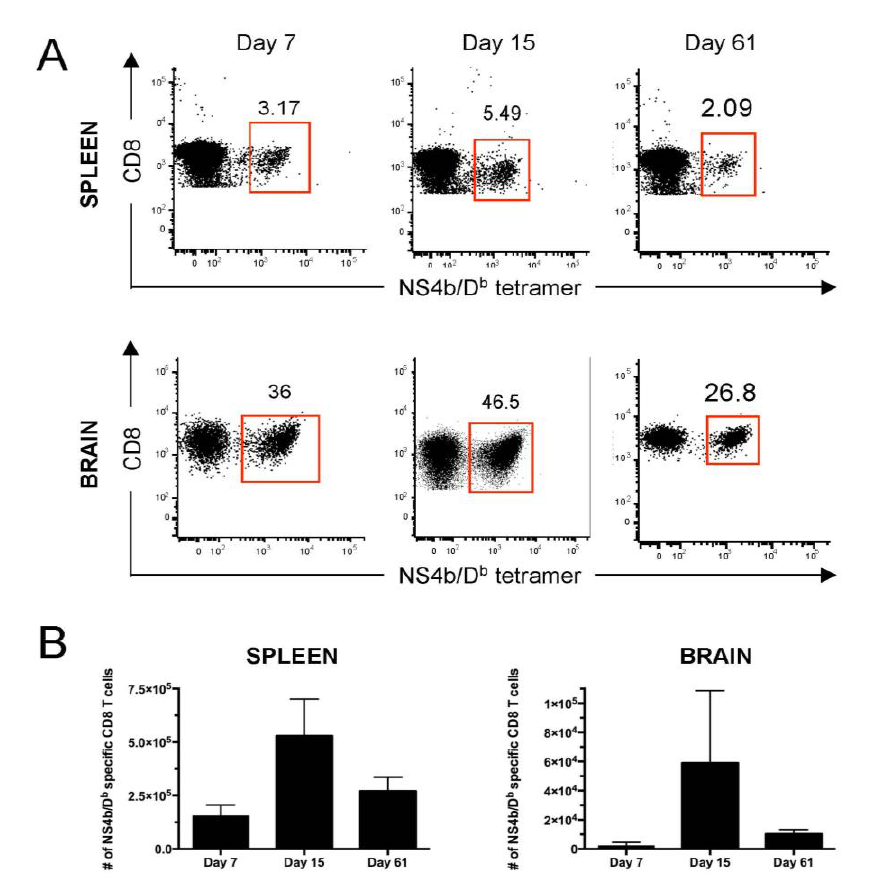
Figure 1. C57Bl/6 mice were infected subcutaneously with 1000 PFU WNV-TX. At the indicated time points post-infection spleen and brain were harvested and cells were isolated. T cells were stained with anti-CD8 antibody and MHC-I tetramer containing the immunodominant epitope within the NS4b protein (SSVWNATTA) and analyzed by flow cytometry. ( A ) Representative dot plots gated on CD8+ cells; ( B ) Total number of NS4b/D b + cells from two experiments combined (n =